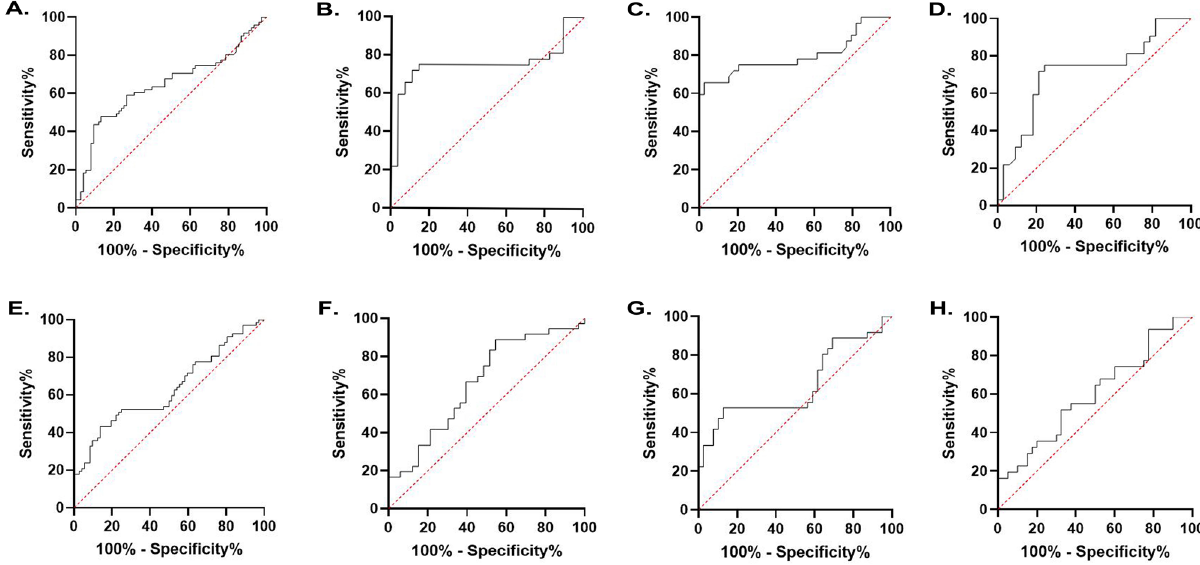
Figure 3. ROC curve analysis for determining statistically significant differences between study groups . (A) ROC curve of all patients and healthy controls analyzed for relative expression level of IL7R (AUC: 0.66, P value = 0.0014). ( B ) ROC curve of sporadic patients and FDR groups analyzed for relative expression level of IL7R (AUC: 0.75, P value = 0.0007). ( C) ROC curve of sporadic patients and healthy controls analyzed for relative expression level of IL7R (AUC: 0.79, P value < 0.0001). ( D ) ROC curve of sporadic patients and familial patients analyzed for relative expression level of IL7R (AUC: 0.71, P value = 0.0030). ( E ) ROC curve of all patients and healthy controls analyzed for relative expression level of NFATC2 (AUC: 0.63, P value = 0.076). ( F) ROC curve of Familial patients and FDR groups analyzed for relative expression level of NFATC2 (AUC: 0.66, P value = 0.021). ( G) ROC curve of Familial patients and healthy controls analyzed for relative expression level of NFATC2 (AUC: 0.64, P value = 0.028). ( H) ROC curve of Familial patients and healthy controls analyzed for relative expression level of RNF213 (AUC: 0.67, P value = 0.014). Variable Covariate Sporadic patients Familial patients All